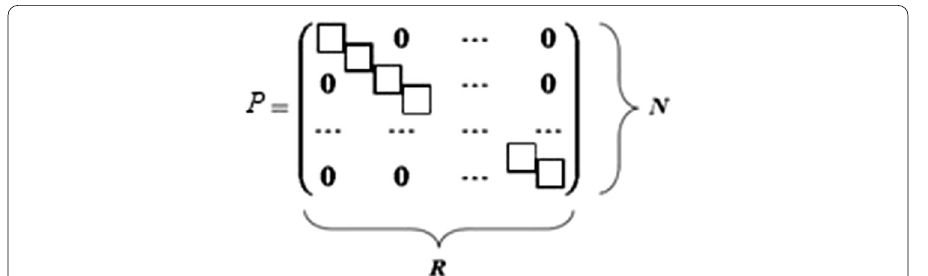
Fig. 5 Schematic planning matrix, where squares are square Hermite polynomials; R is the quantity of spline merging nodes on the observing interval